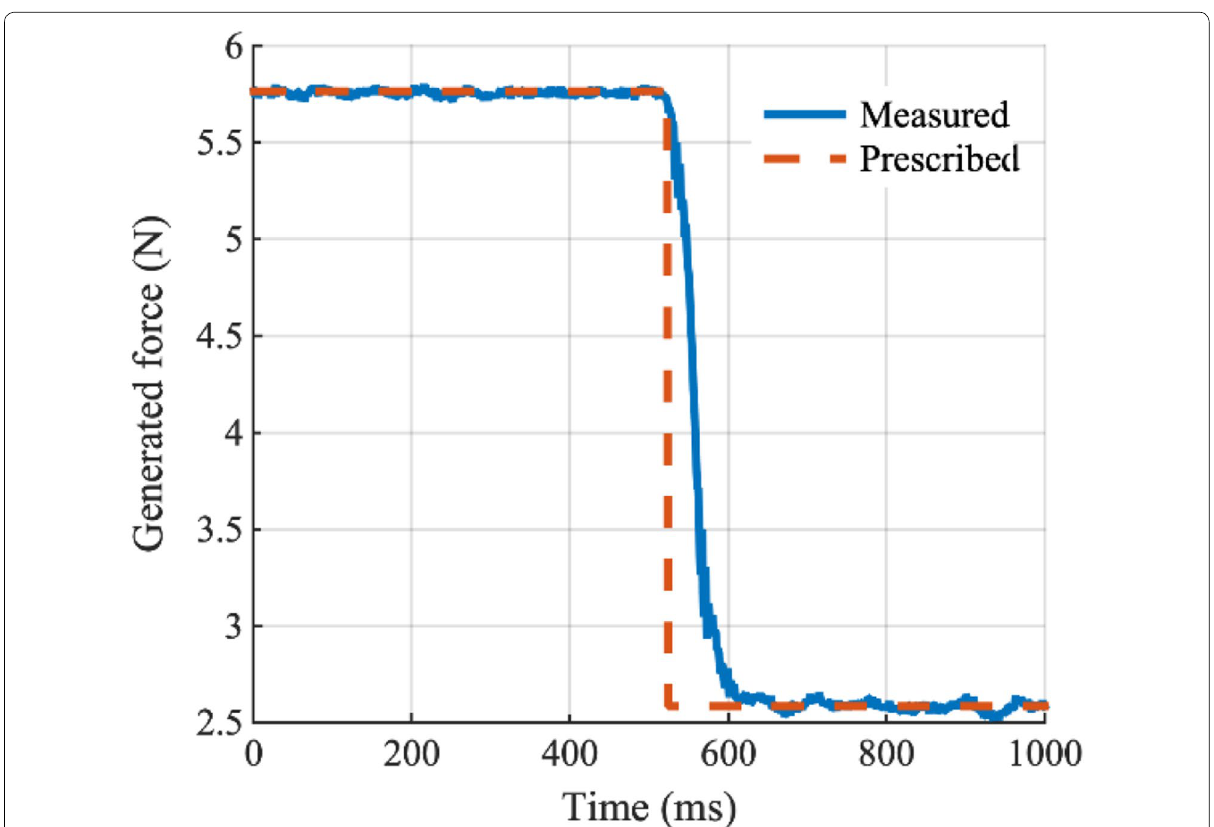
Figure 11 Response of the stiffness